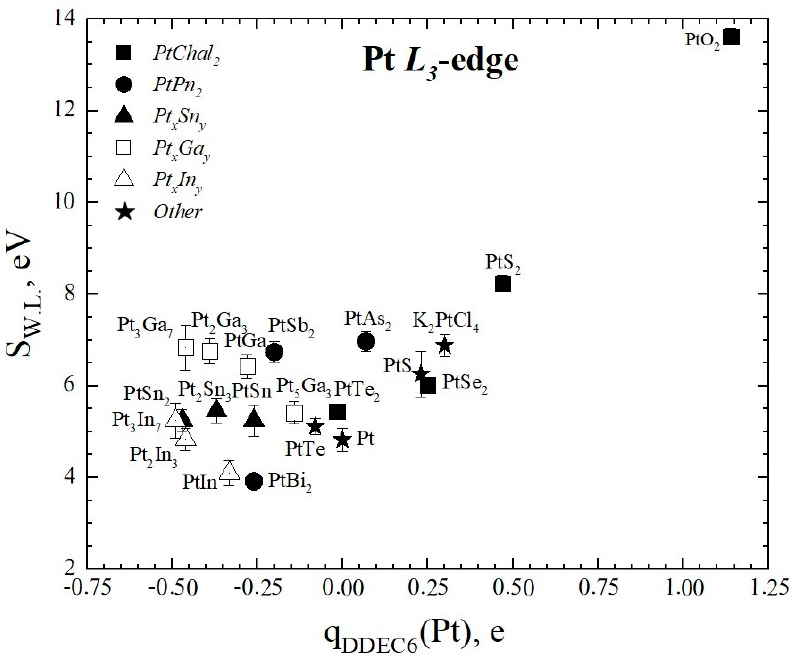
Figure 4. The white line area (S W.L. ) of Pt L 3 -edge spectra vs. DDEC6 Pt partial atomic charge.